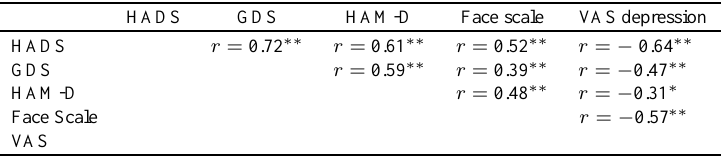
Table 2 Spearman correlation coefficients between the different depression scales HADS GDS HAM-D Face scale VAS